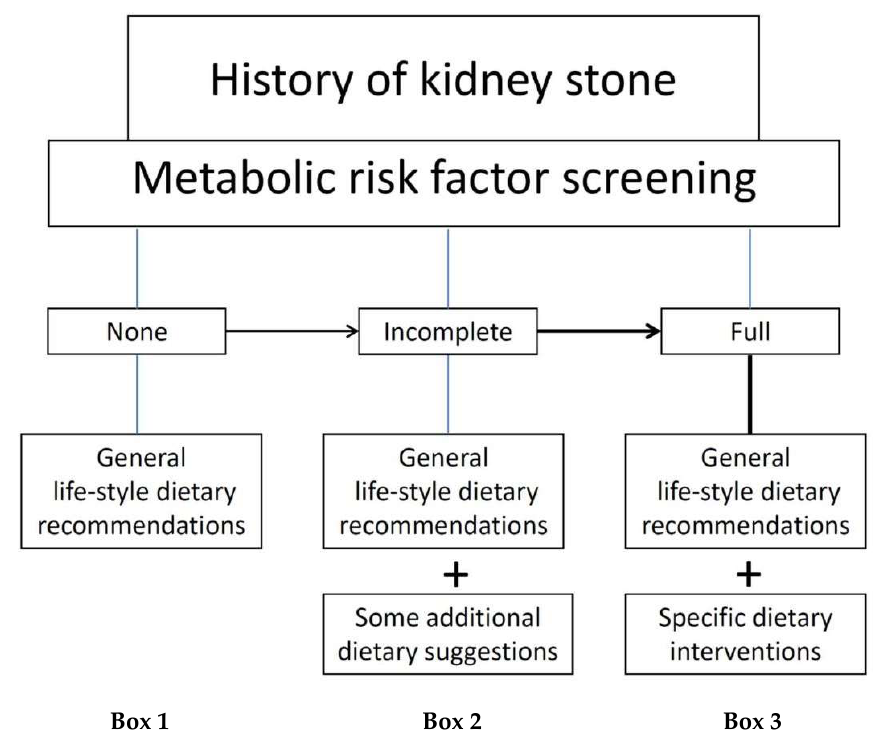
Figure 1. Di ff erent type of dietary approach (see Box 1–2–3) on the basis of the diagnosis accuracy level. (a) Patients who reported renal colic episodes and / or passed stones with no information on stone composition and / or on urinary risk factors and / or on metabolic cardiovascular risk